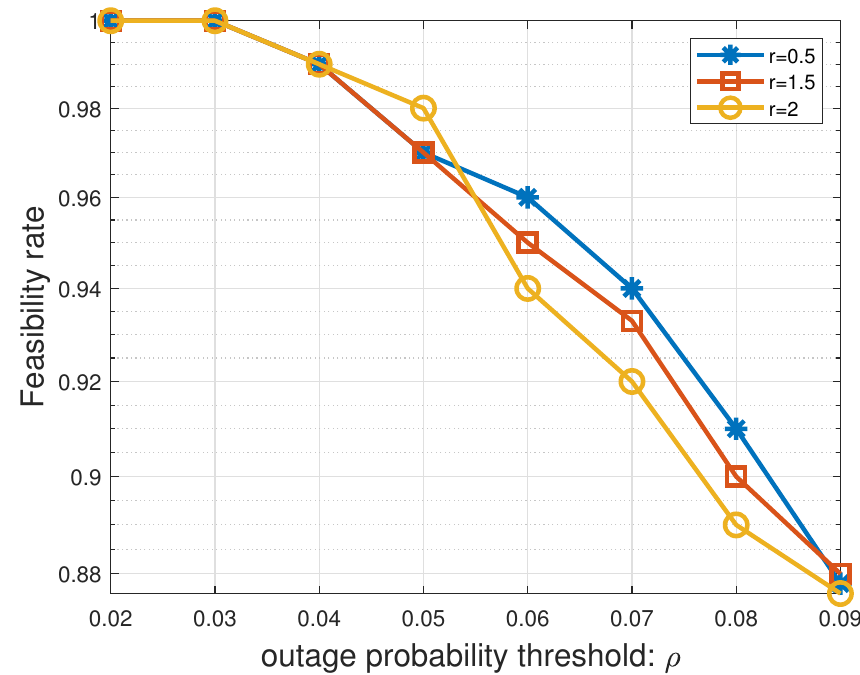
Figure 7. Feasibility rate versus rate outage probability threshold ρ , when L = 2